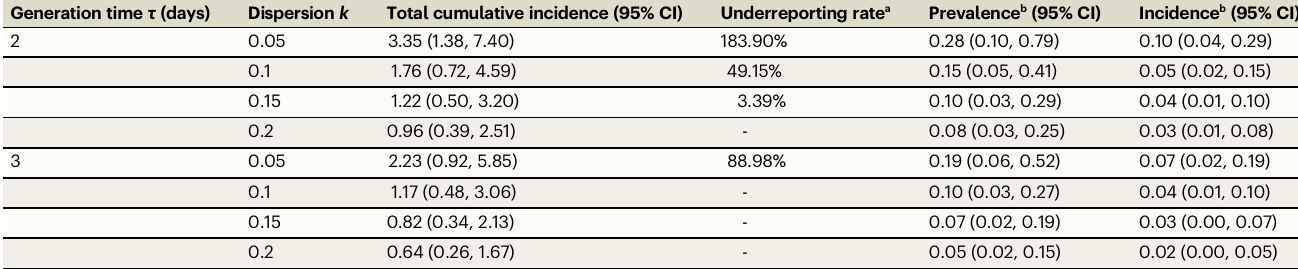
Table 1 | Prevalence and incidence under various levels of generation time ( τ ) and dispersion ( k ) Generation time τ